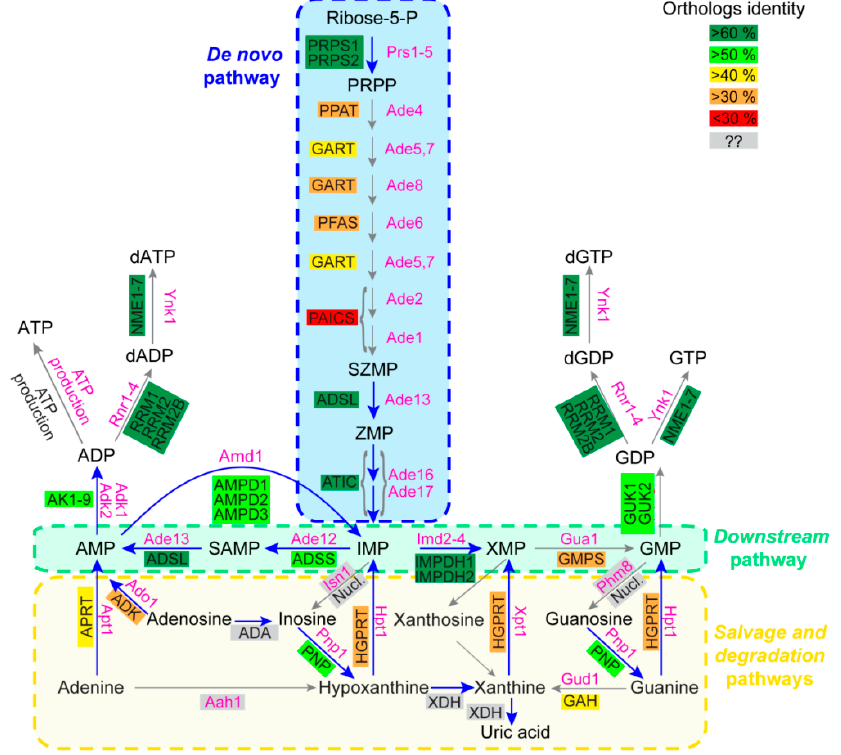
Figure 1. Schematic representation of the human and Saccharomyces cerevisiae purine biosynthesis pathways. Features of human and yeast enzymes are listed in Table A1, Table A2 and are shown in black and pink, respectively. For human enzymes, the numerous isoforms detected for some enzymes are not presented. Ortholog identity scores were determined as described in supplementary Table A3. Grey boxes correspond to enzymes with no or unidentified orthologs between yeast and human.